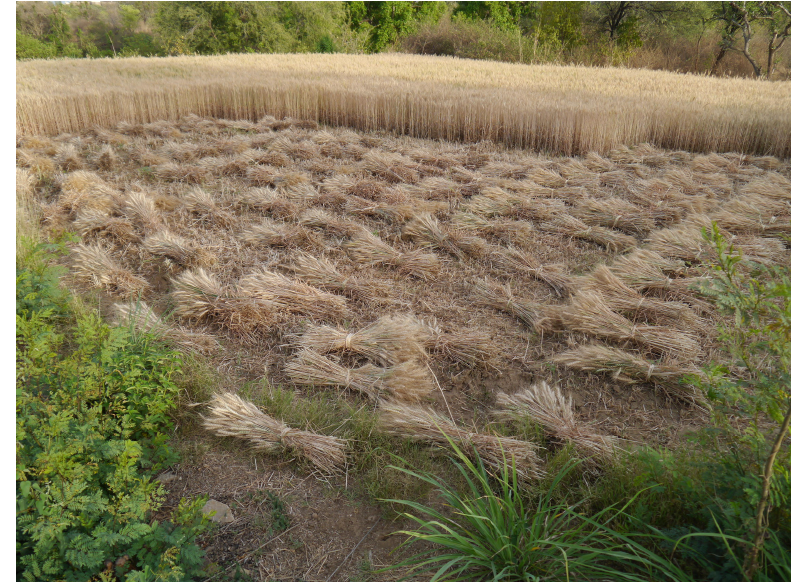
Figure 2. Wheat harvest in Badi: Lakshmi’s “gift of gold”—photo by Notermans, March